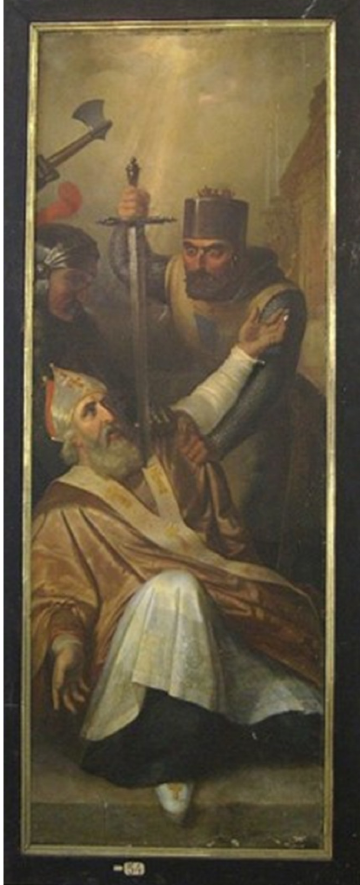
Figure 6. Basile Quesnel, Murder of Thomas Becket , circa 1850, oil/canvas, N° INV. 939.P.67, Musée Quesnel-Morinière, Coutances. © musée Quesnel-Morinière, Coutances. (with kind permission).